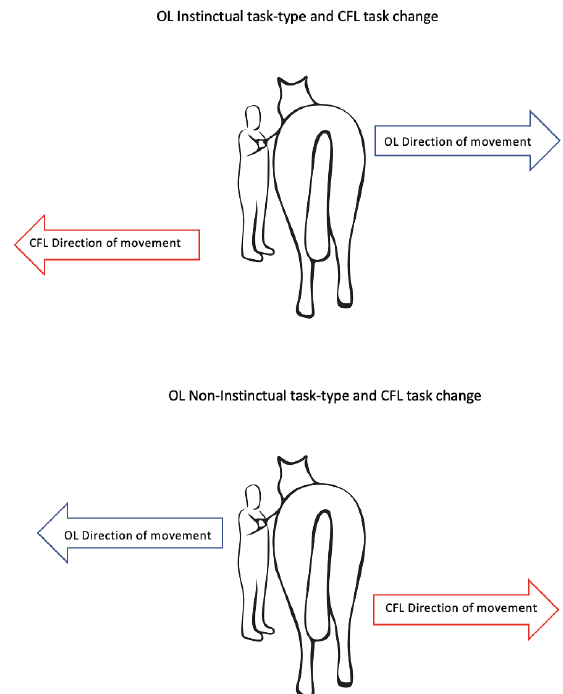
Figure 1. Diagram of the direction of movement for the IS and NIS task types during original learning (OL) and then the direction change during the cognitive flexibility learning (CFL).